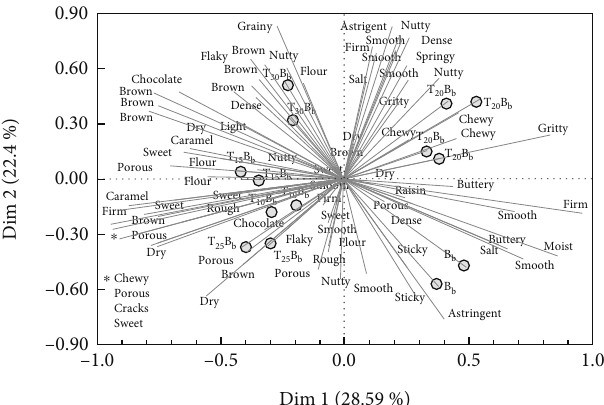
Figure 6: Generalized Procrustes Analyses of group average plots for descriptors of butter bread substituted with tiger nut fl our. In the (Butter bread), partial substitution of wheat fl our with 10% tiger nut fl our (T consensus space that is B b